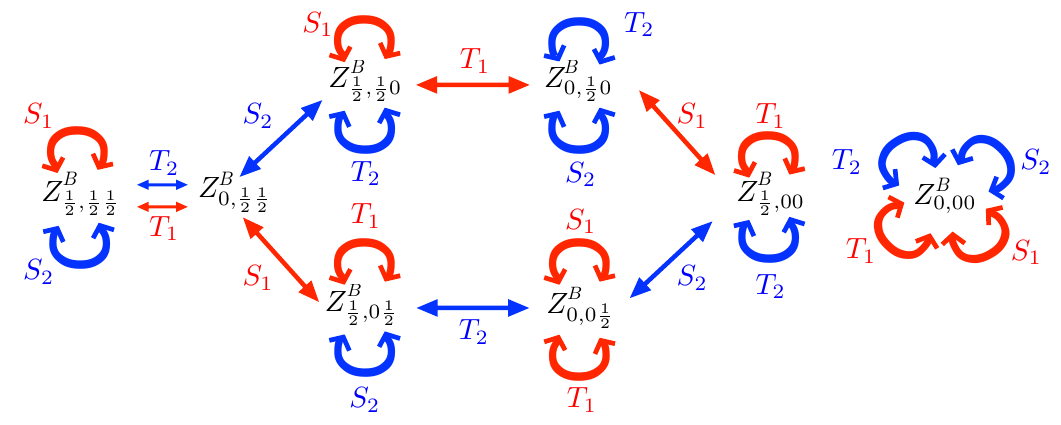
Figure 10 . Action of the three-dimensional modular group on the bosonic partition functions Z B (cid:11) 0 ;(cid:11) 1 (cid:11) 2